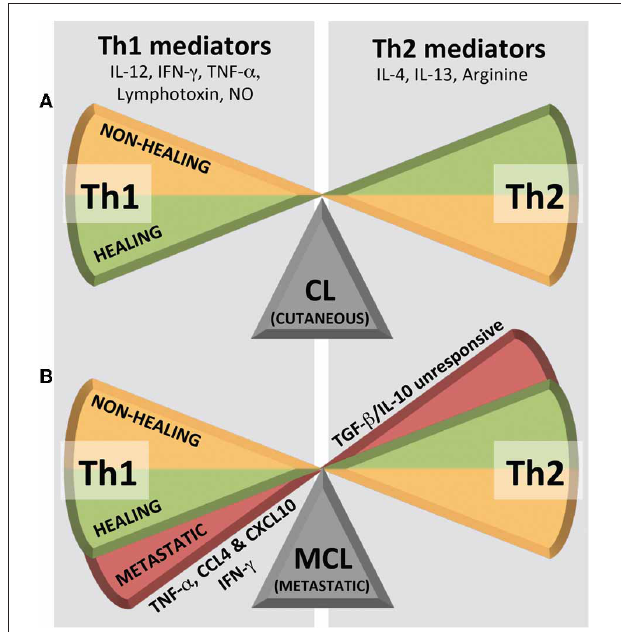
FIGURE 4 | Immunological Th1/Th2 dogma in leishmaniasis. (A) Cutaneous leishmaniasis (CL) shows a simple, graded bipolar phenotypic range while (B) metastatic/mucocutaneous leishmaniasis (MCL) shows its third phenotype in a Th1 extreme. NO, nitric